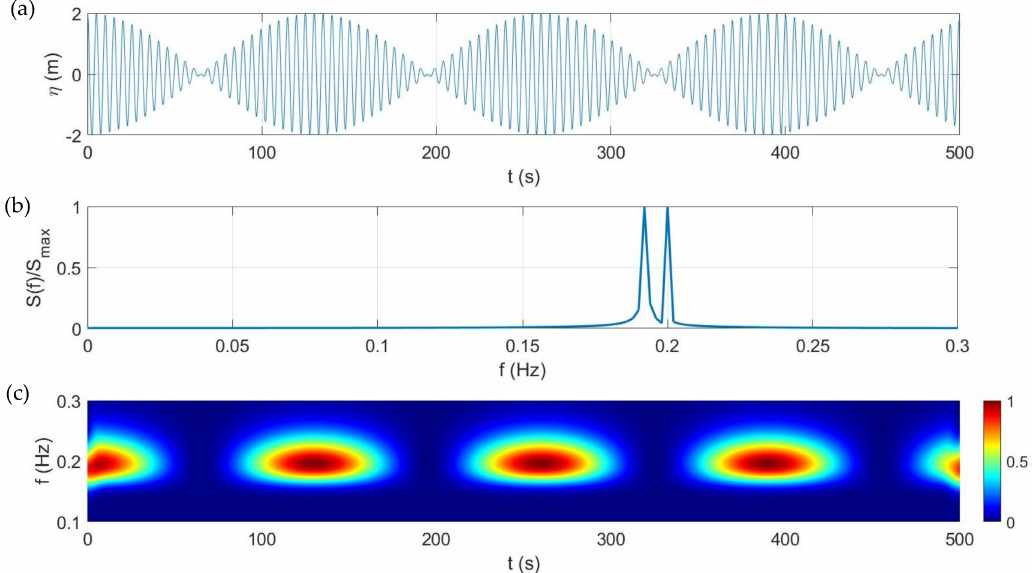
Figure 1. Wave group signal time series ( a ) and corresponding spectra using di ff erent methodologies: ( b ) dimensionless Fourier spectrum; ( c ) dimensionless Wavelet